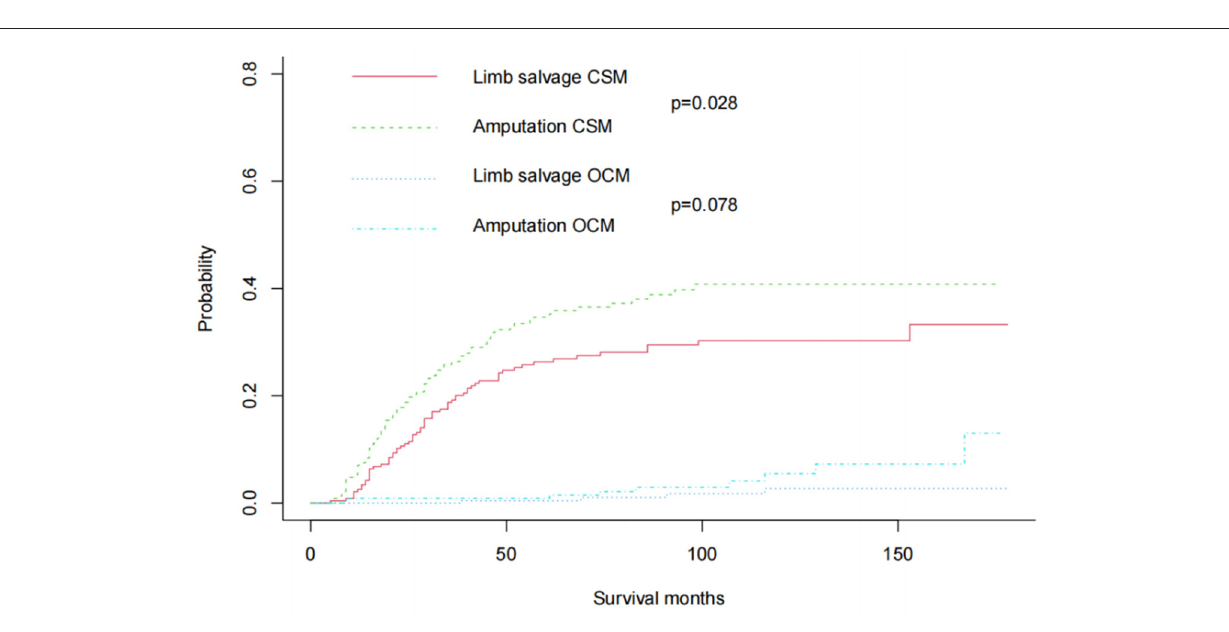
FIGURE 4 | After 1:1 propensity score matching, Cumulative incidence plots showed CSM and OCM rates in pediatric patients with Osteosarcoma of the